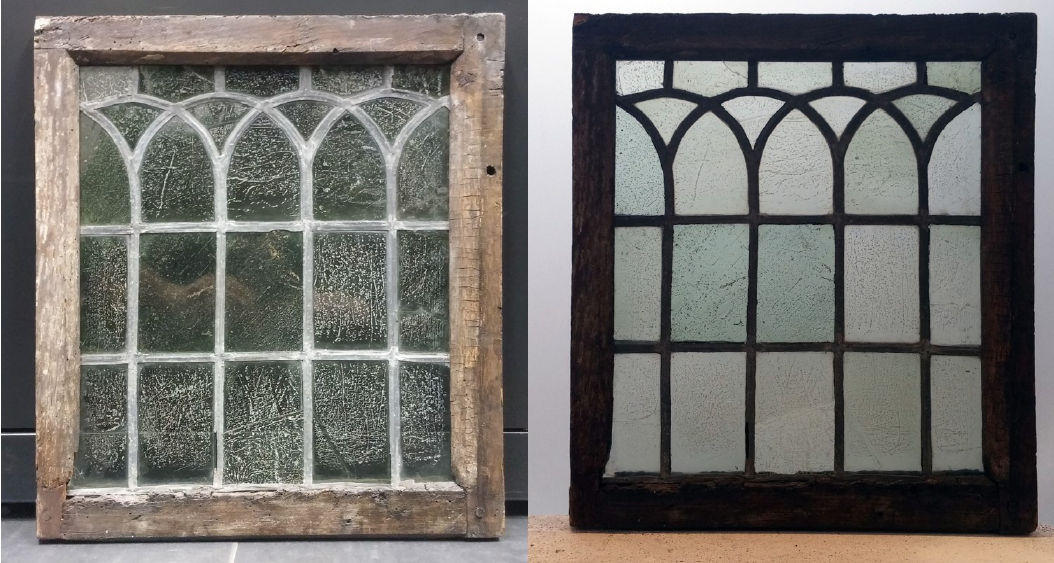
Figure 1. Visual light images of the interior side of the inspected window in reflected ( left ) and transmitted light ( right